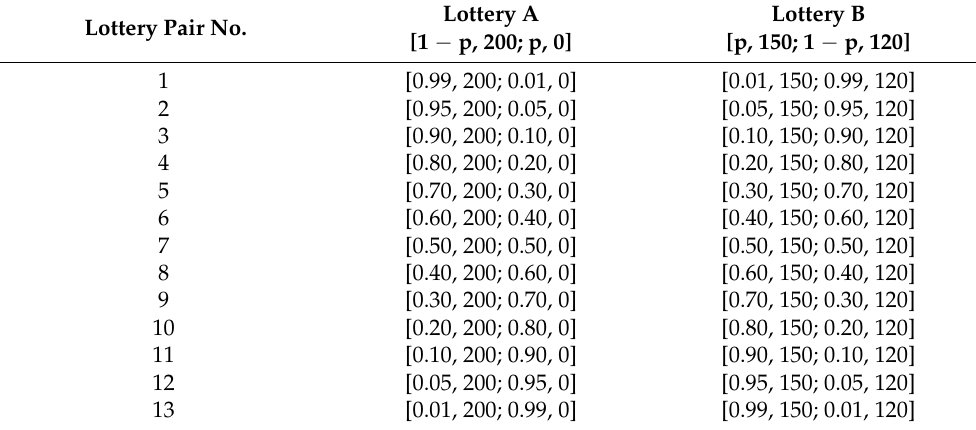
Table 1. Lottery